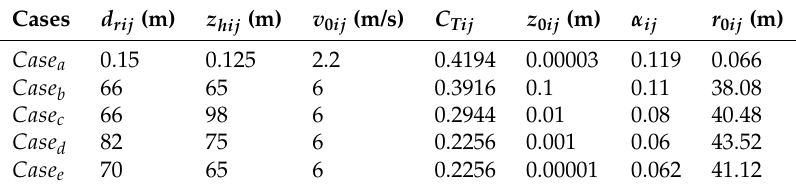
Table 1. Different experiments and Large-Eddy Simulation (LES) case to validate the Generalized model of OSWFs in Yangshan port,